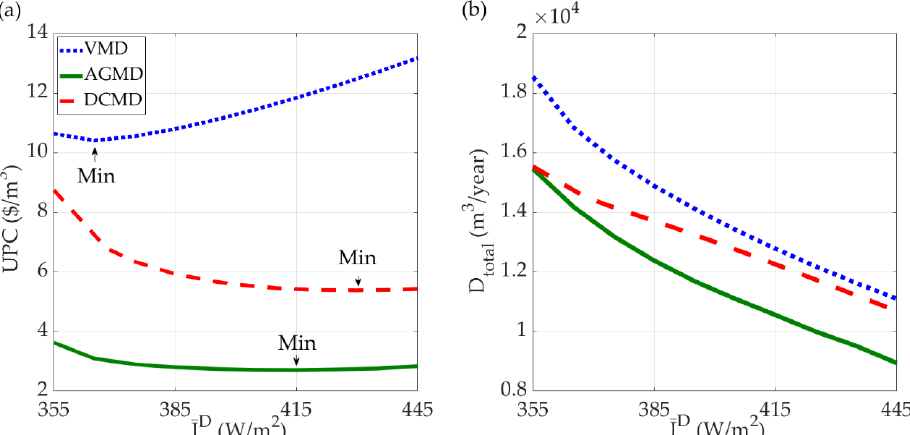
Figure 7. The ( a ) UPC and ( b ) annual water production rate of solar-driven MD systems under dynamic control with yearly solar radiation intensity of Taiwan. The optimal equipment sizes determined from the first design stage for each I̅ D are used.